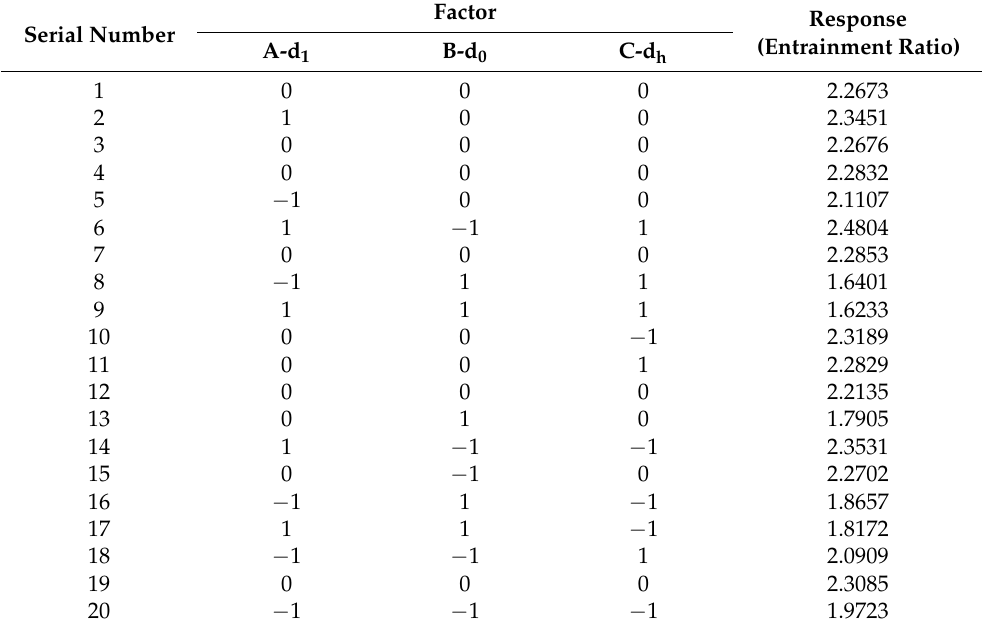
Table 6. Test results of central composite design.